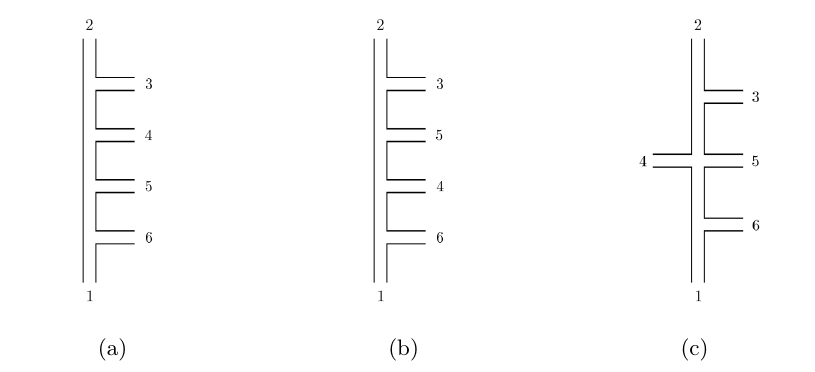
Figure 5 . The colour connections of the three representative colour orderings we discuss in this paper, displayed on a two-sided rapidity plot: (a) σ ; (b) σ ; (c) σ , which uses ’t Hooft graphical A A 0 B notation, with untwisted colour lines. Modulo cyclic permutations of the colour ordering, the gluons which fall between incoming gluons 2 and 1 are placed on the “front” side of the plot, while the gluons which fall between 1 and 2 are placed on the “back” side. In MRK, the gluons are ordered in rapidity both on the front and on the back sides, however the relative ordering between the two sides is immaterial [75, 95]. On the front side, colour and rapidity have the same ordering; on the back, the opposite ordering. In NMRK, the strict orderings may be relaxed on either side as appropriate